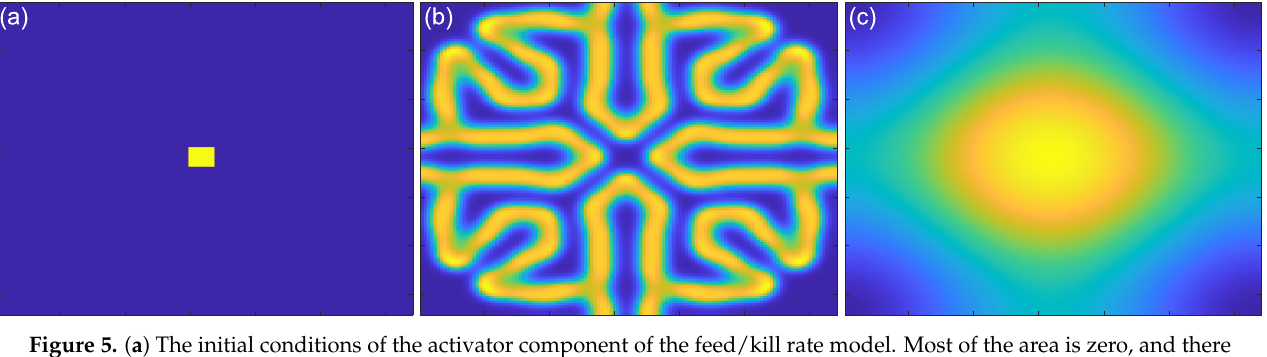
Figure 5. ( a ) The initial conditions of the activator component of the feed/kill rate model. Most of the area is zero, and there is a central peak seeded at 1, assumed to be due to random fluctuation. ( b ) The end point of the feed/kill rate model (5000 simulated seconds, with 4 iterations per second). The diffusion rate of the inhibitor (1) is double that of the activator (0.5). ( c ) The end point of the feed/kill rate model (5000 simulated seconds, with 4 iterations per second), when the diffusion rate of the inhibitor (1) is equal that of the activator